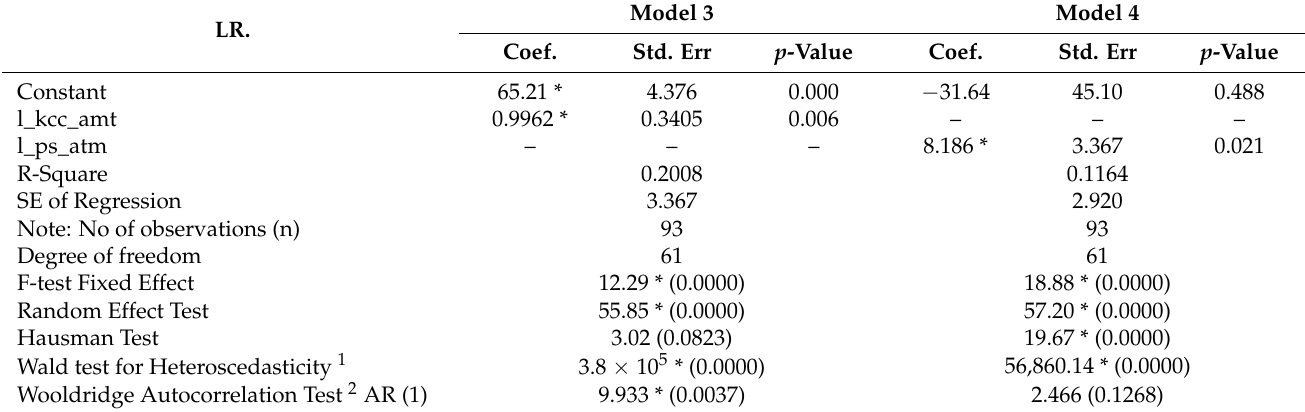
Table 5. Result of Regression Analysis (Static Panel Data Analysis).